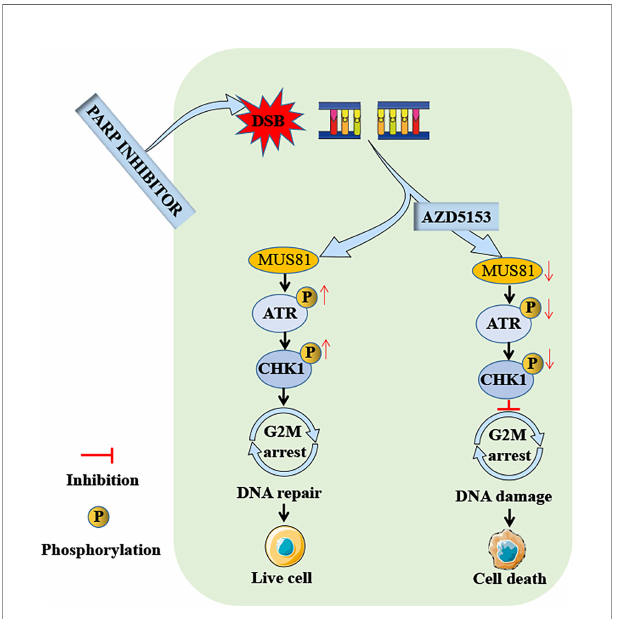
FIGURE 7 | Schema of the antitumor effect of AZD5153 sensitizing gastric cancer cells to talazoparib. AZD5153 inhibits the ATR/CHK1 pathway activated by DNA damage by downregulating MUS81 expression, causing gastric cancer cells to continue mitosis with damaged DNA, ultimately leading to cell